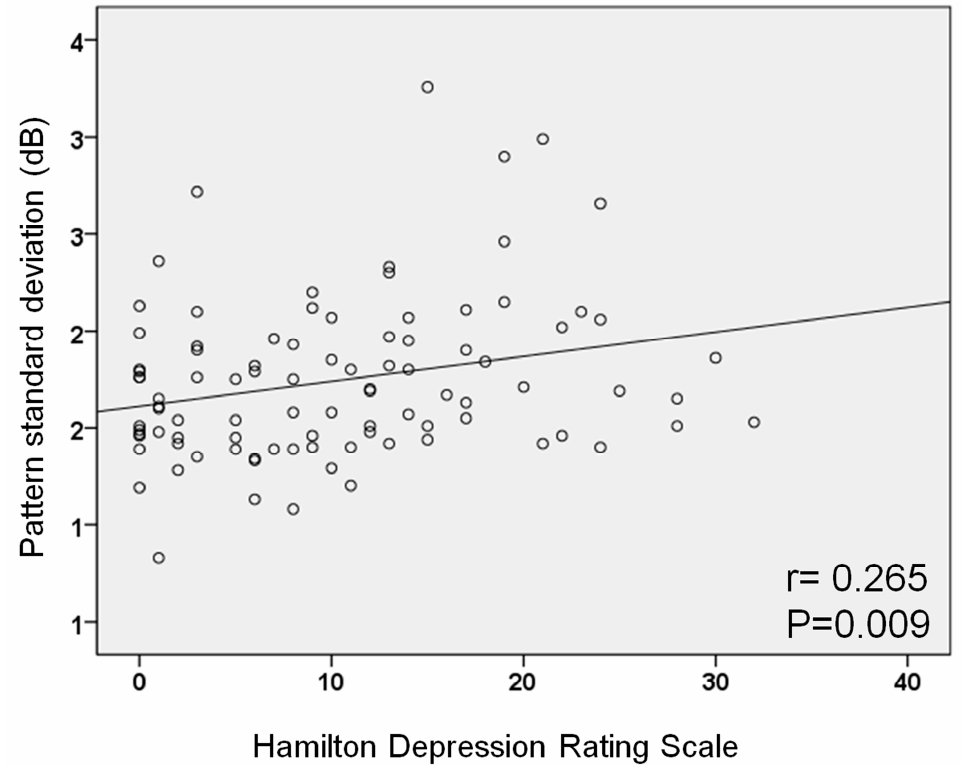
Figure 2. Correlations between Hamilton Depression Rating Scale (HDRS) score and pattern standard deviation (PSD) on visual field test. The severity of depression as measured by the HDRS was positively correlated with